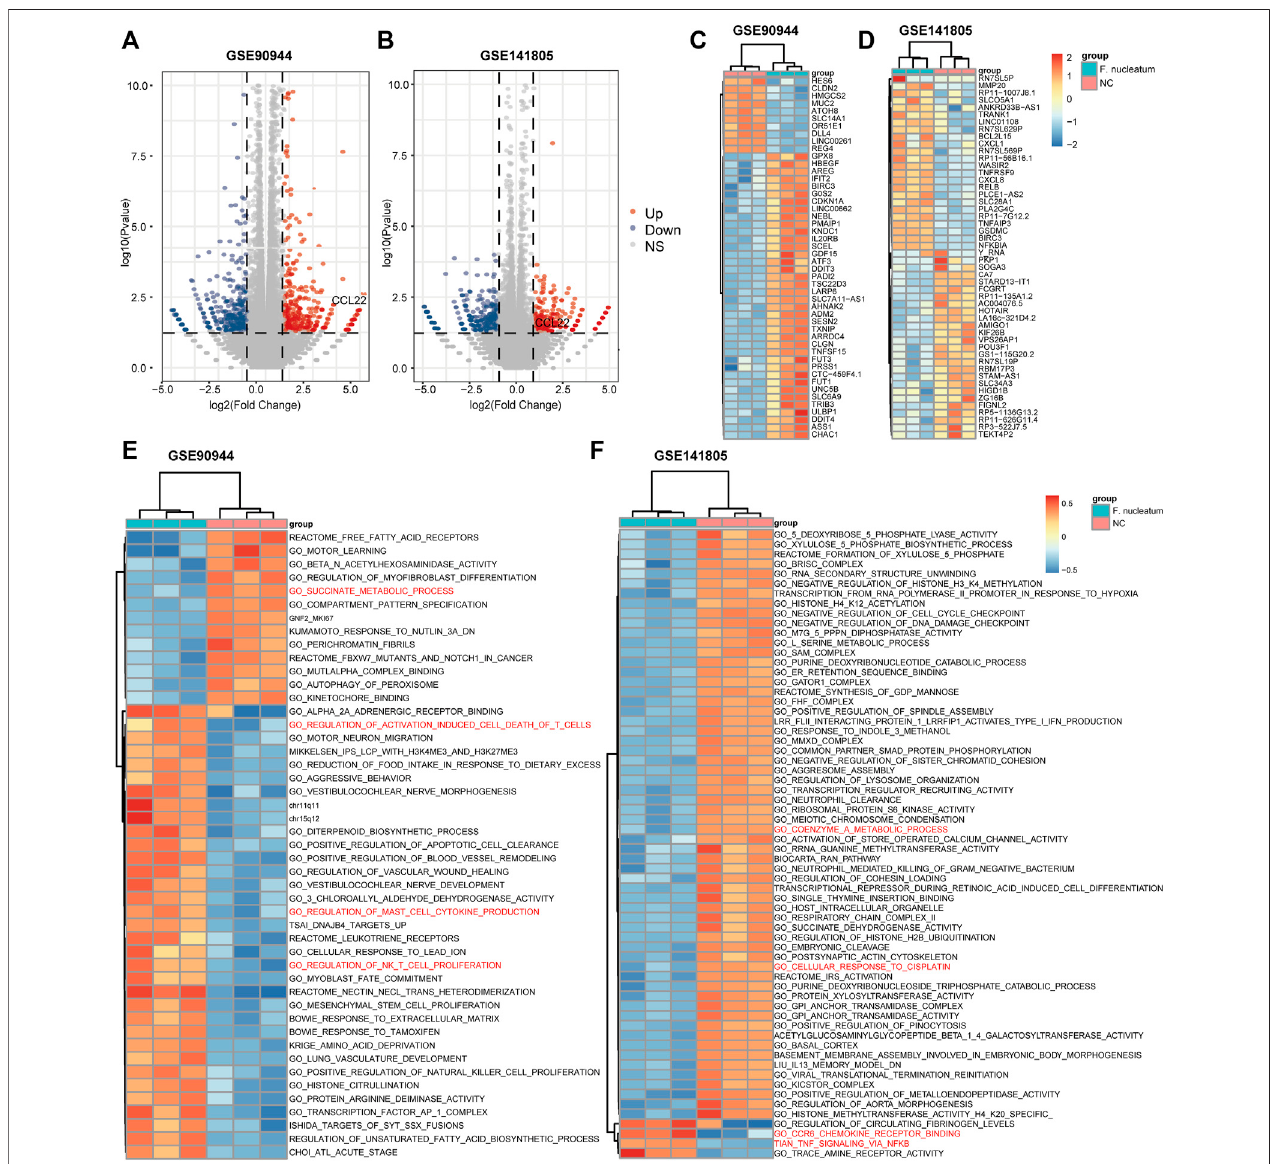
FIGURE 2 | Differentially expressed genes (DEGs) and biological functions affected by F. nucleatum . (A , B) Volcano plots of DEGs in fl uenced by F. nucleatum infection. Red dots represent upregulated genes, while blue dots represent downregulated genes. DEGs were selected based on p -value < .05 and |log2FC| ≥ 1. Heat maps of the top 50 DEGs (C , D) and biological functions (E , F) between F. nucleatum -infected and uninfected colorectal cancer